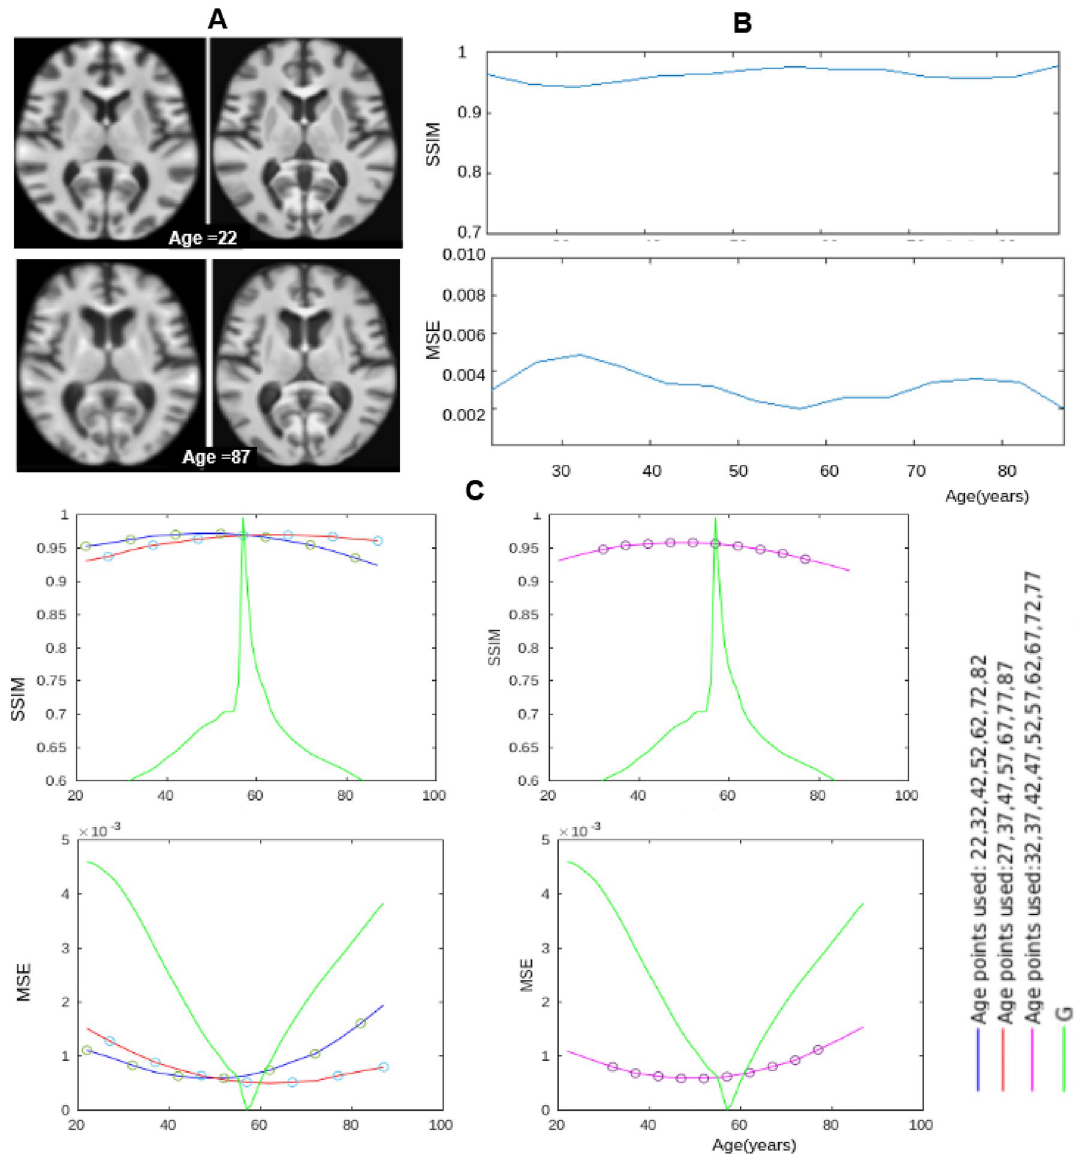
Figure 7. ( A ) Qualitative assessment of templates (first image in each pair) given in the Neurodev dataset against those generated by the proposed aging model (second image in each pair). Only the templates for the first and last time points are shown. ( B ) Quantitative assessment with SSIM (top) and MSE (bottom) values between given templates and generated templates. ( C ) Interpolation (left) and extrapolation (right) assessment with SSIM (top) and MSE